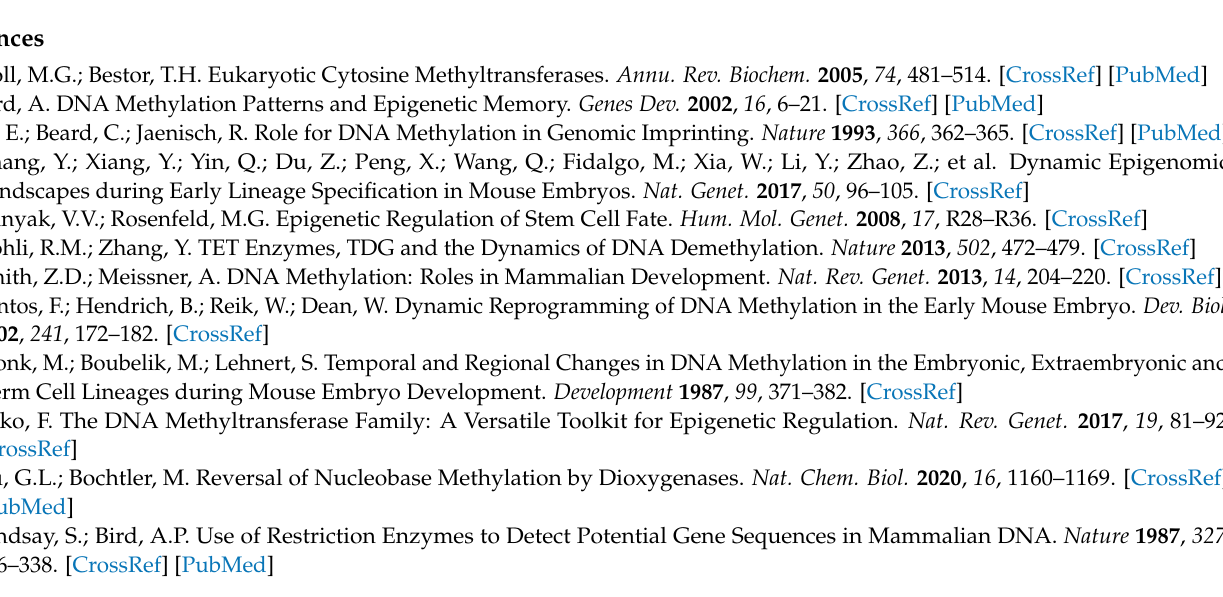
validation, Figure S2: D2-MSN AM-seq and EM-seq quality analysis, Figure S3: NAc D2-MSN methylome characterization, Figure S4: D2-MSN UMR analysis, Figure S5: NAc D2-MSN-specific CpG DMRs, Figure S6: NAc D2-MSN non-CpG methylation, Table S1: DNA input and yield of D2-MSN methylomes, Table S2: Sequencing reads processing, Table S3: Statistics of the four D2-MSN methylomes, Table S4: D2-MSN unmethylated regions (UMRs), Table S5: Four categories of CGI/UMR related genomic regions, Table S6: Transcription factor motifs enriched in CGI/UMR regions, Table S7: List of KEGG pathways enriched in genes associated with four categories of CGI/UMR regions, Table S8: CpG DMRs of D2-MSNs vs. NPCs, Table S9: CpG DMRs of D2-MSNs vs. PFC CamKIIa+ neurons. Table S10: D2-MSN autosomal CpG DMRs used for K-means clus- tering analysis, Table S11: List of enriched GO terms for seven clusters of D2-MSN CpG DMRs, Table S12: Transcription factors matched by D2-MSN CpG DMR motif analysis, Table S13. Genes with high non-CpG methylation in both D2-MSNs and PFC excitatory neurons, Table S14: Non-CpG methylation DMRs comparing D2-MSNs to PFC CamKIIa+ neurons, Table S15: List of enriched GO terms for D2-MSN non-CpG